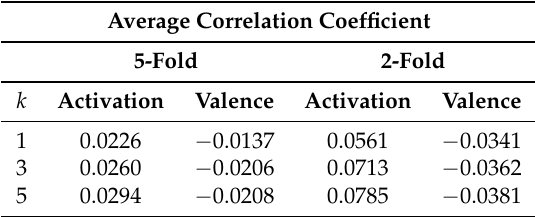
Table 3. Average Correlation Coefficient of Predicted Labels for 2- and 5-fold